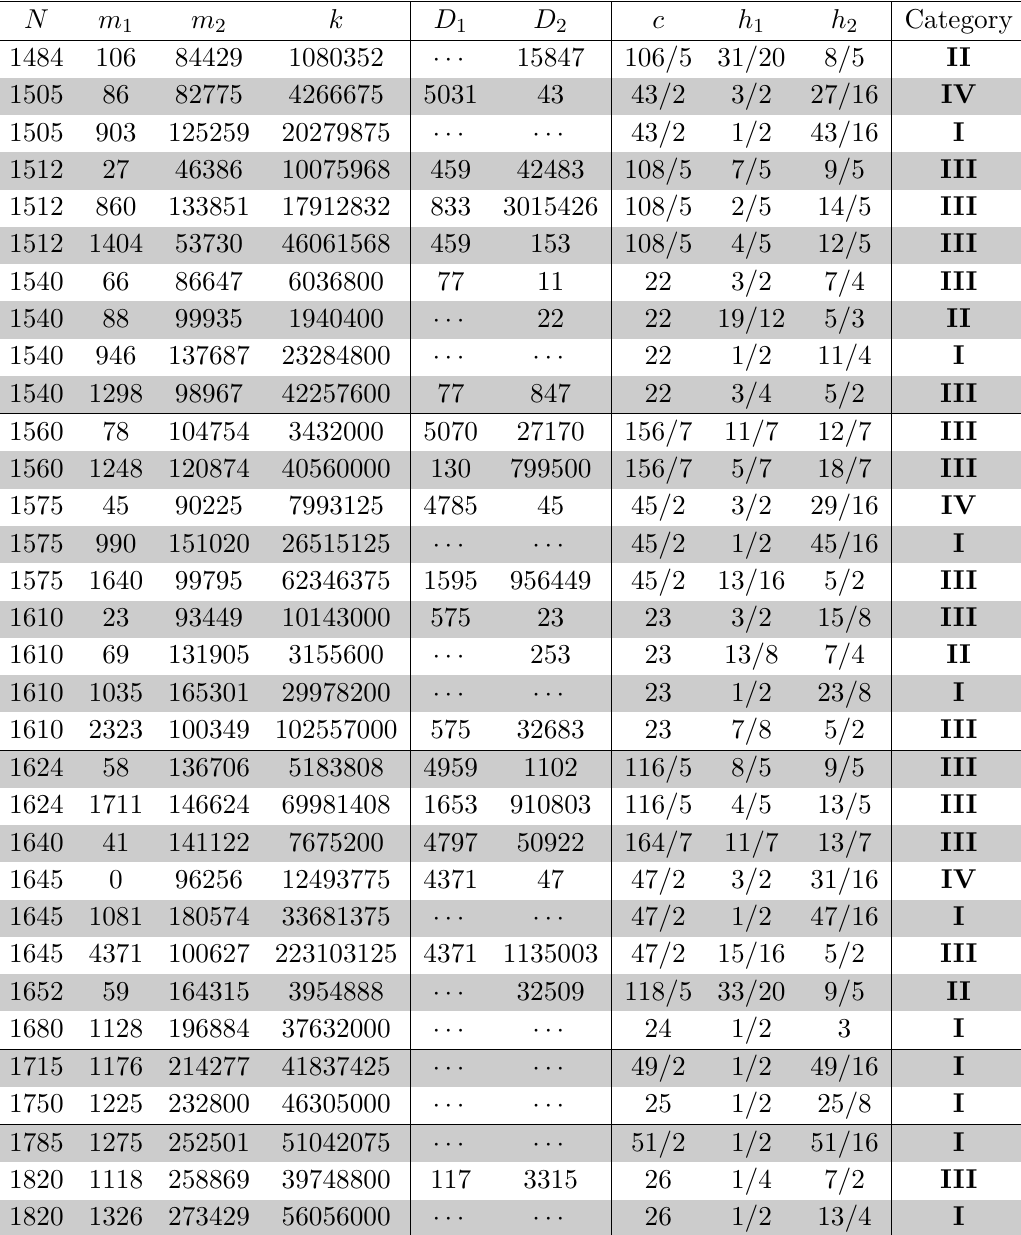
Table 15 . Solutions to the [ 3 , 0 ] MLDE with 21 < c ≤ 26